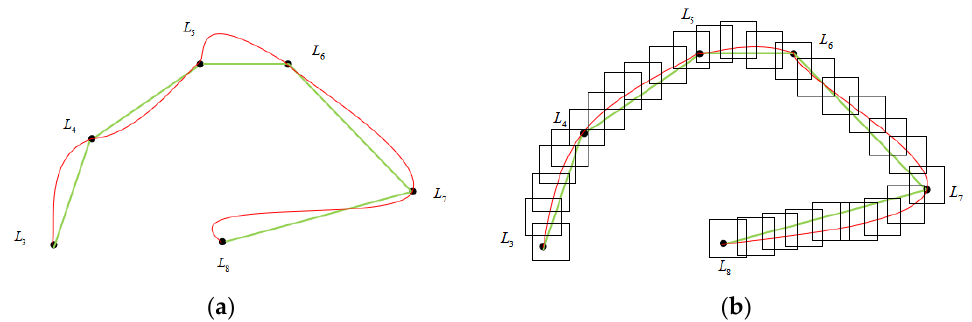
Figure 7. Schematic diagram of trajectory optimization comparison: ( a ) trajectory without corridor constraint; ( b ) trajectory with corridor constraint added.